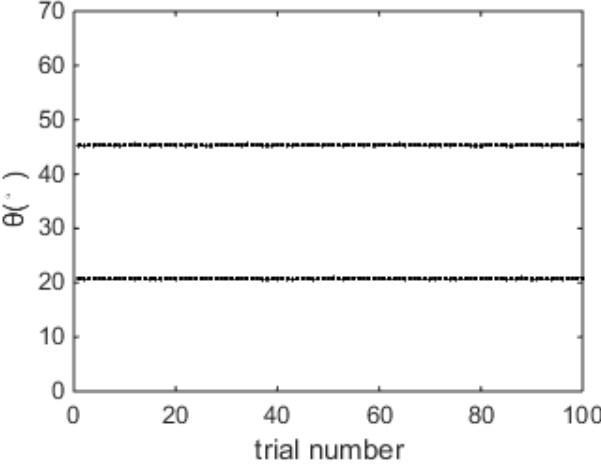
Figure 3. DOA estimation results over 100 trials (SNR = 0dB).